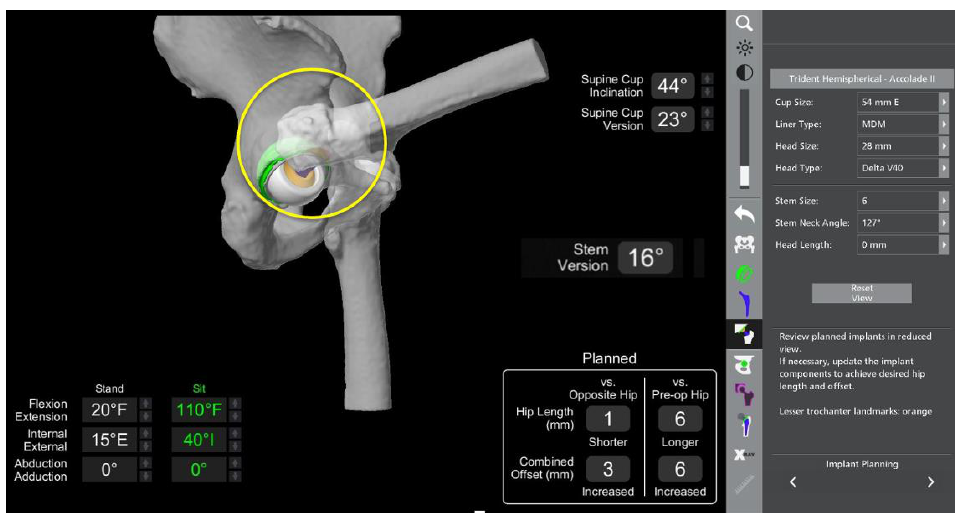
Figure 11. ( a ) VROM in extension with no obvious impingement. ( b ) VROM in extension (yellow circle) with subtraction of the implant showing a small area of anterior impingement (red area indi- cated by yellow arrow).